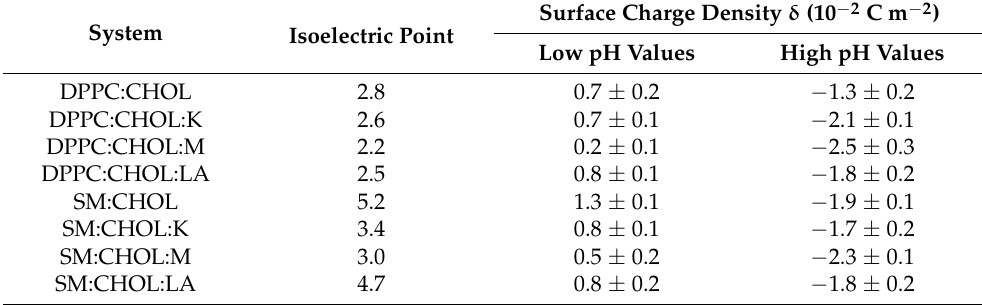
Surface charge densities and isoelectric points for (DPPC:CHOL), (DPPC:CHOL:K), (DPPC:CHOL:M), (DPPC:CHOL:LA), (SM:CHOL), (SM:CHOL:K), (SM:CHOL:M) and (SM:CHOL:LA)